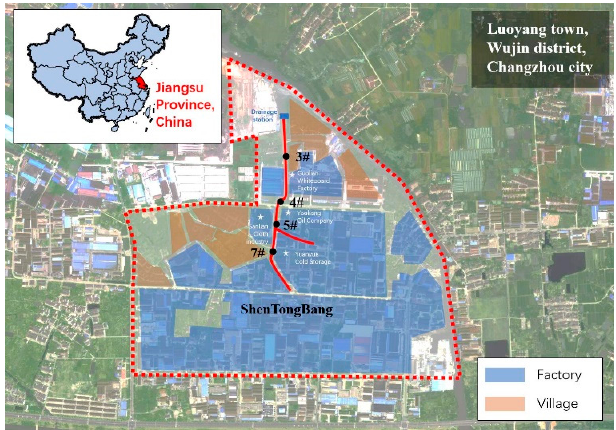
Figure 1. Sampling sites of overlying water in